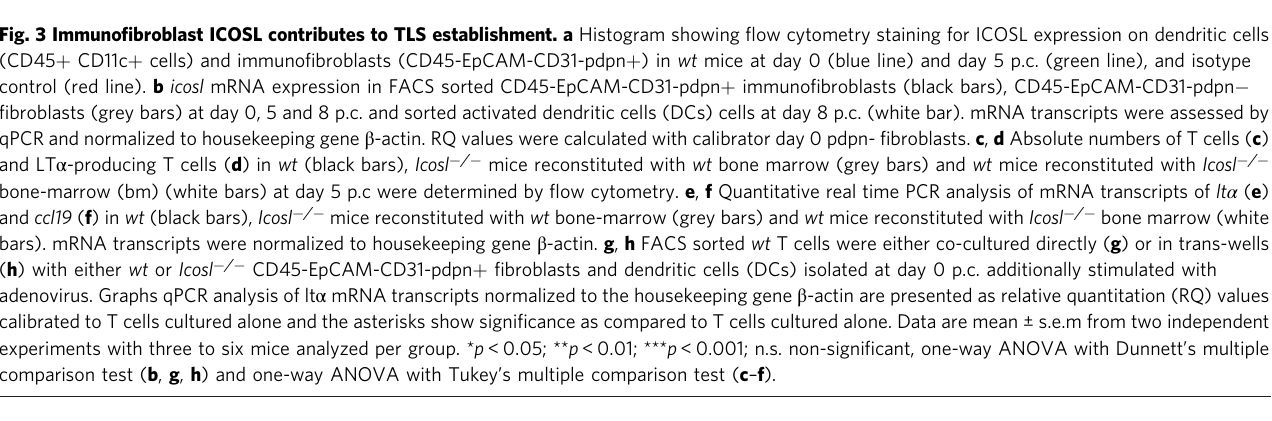
Fig. 3 Immuno fi broblast ICOSL contributes to TLS establishment. a Histogram showing fl ow cytometry staining for ICOSL expression on dendritic cells (CD45 + CD11c + cells) and immuno fi broblasts (CD45-EpCAM-CD31-pdpn + ) in wt mice at day 0 (blue line) and day 5 p.c. (green line), and isotype control (red line). b icosl mRNA expression in FACS sorted CD45-EpCAM-CD31-pdpn + immuno fi broblasts (black bars), CD45-EpCAM-CD31-pdpn − fi broblasts (grey bars) at day 0, 5 and 8 p.c. and sorted activated dendritic cells (DCs) cells at day 8 p.c. (white bar). mRNA transcripts were assessed by qPCR and normalized to housekeeping gene β -actin. RQ values were calculated with calibrator day 0 pdpn- fi broblasts. c , d Absolute numbers of T cells ( c ) and LT α -producing T cells ( d ) in wt (black bars), Icosl − / − mice reconstituted with wt bone marrow (grey bars) and wt mice reconstituted with Icosl − / − bone-marrow (bm) (white bars) at day 5 p.c were determined by fl ow cytometry. e , f Quantitative real time PCR analysis of mRNA transcripts of lt α ( e ) and ccl19 ( f ) in wt (black bars), Icosl − / − mice reconstituted with wt bone-marrow (grey bars) and wt mice reconstituted with Icosl − / − bone marrow (white bars). mRNA transcripts were normalized to housekeeping gene β -actin. g , h FACS sorted wt T cells were either co-cultured directly ( g ) or in trans-wells ( h ) with either wt or Icosl − / − CD45-EpCAM-CD31-pdpn + fi broblasts and dendritic cells (DCs) isolated at day 0 p.c. additionally stimulated